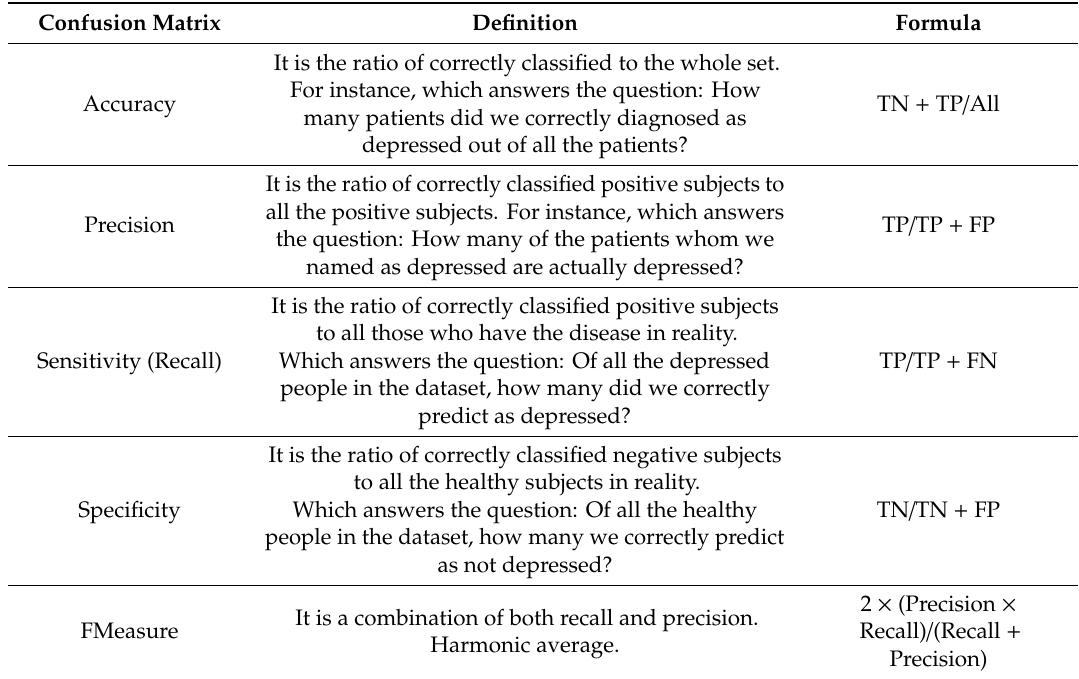
Table 1. Confusion Matrix